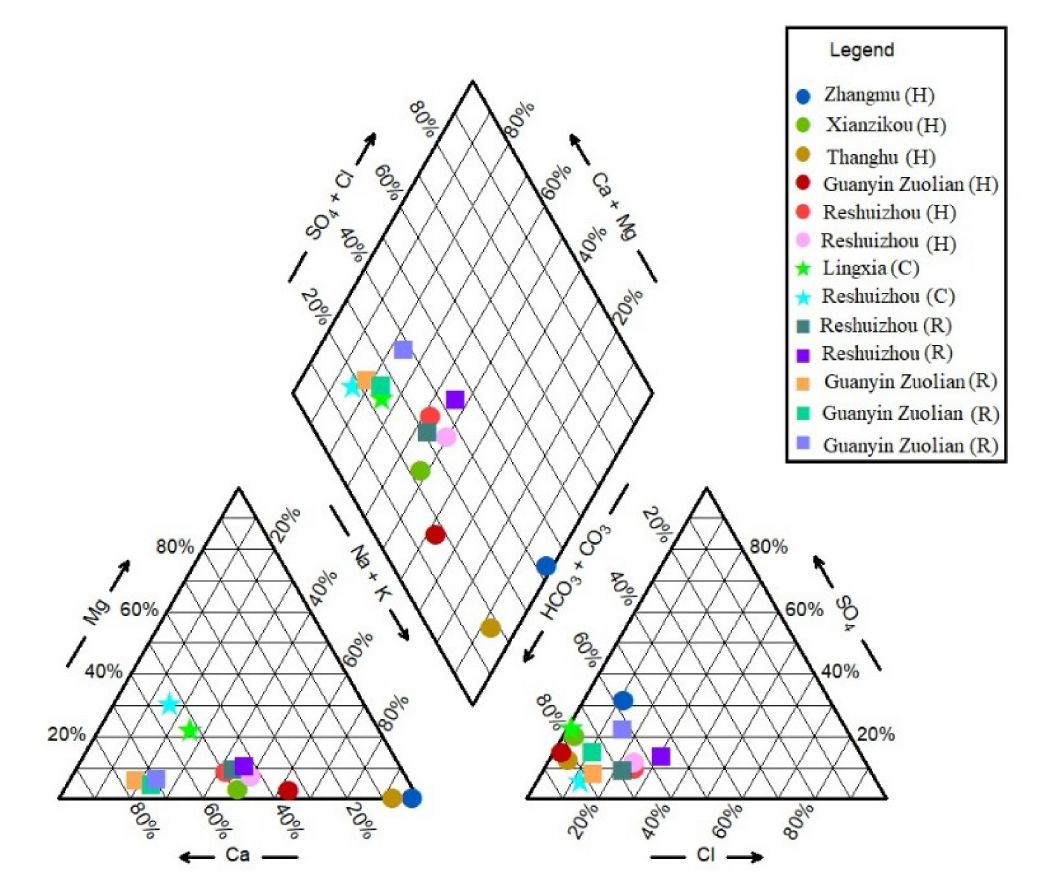
Figure 3. Piper plot for Suichuan geothermal field (Thermal and non-thermal groundwater and river water samples). H, C and R are relative terms for hot, cold and river water samples. All the water samples are showing HCO 3 − dominance.